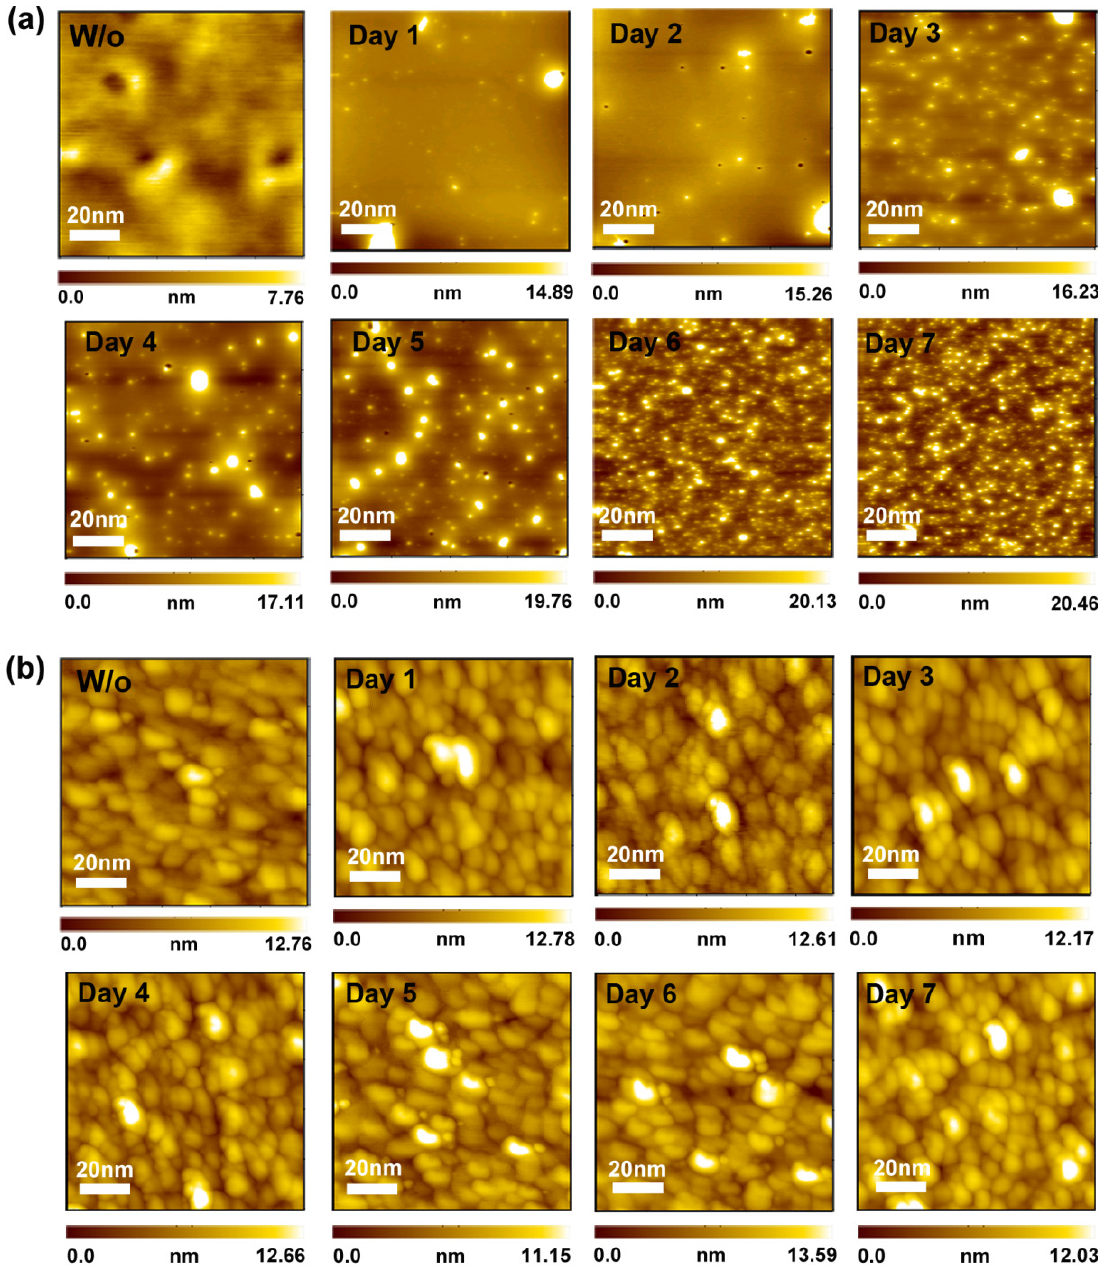
Figure 7. Time-dependent AFM surface morphology images of the pre- and post-sterilization pH-sensitive PSW sensors coated with (a) γ -APTES, and (b) γ